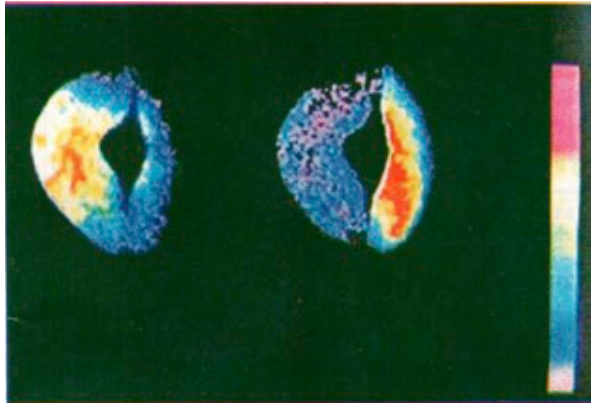
Figure 4. 1 H NMR images of transverse section of a commercial variety of ground nut seed. Left: Water image and right: Oil image. The extreme right shows the scale with the concentration increasing from top to bottom. PERMISSION IN ATTESA